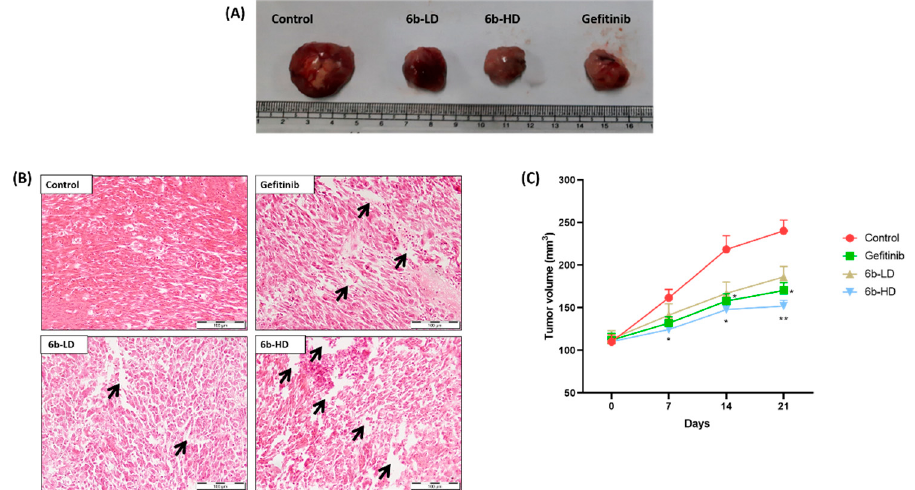
Figure 3. Effect of the 6b compound and gefitinib treatment on the tumor size in A549-induced lung cancer xenografts. ( A ) Representative photographic images of surgically removed tumors depicting tumor growth of xenograft nude mice from different groups in each group. ( B ) Changes in tumor volume of the animals from different groups throughout the treatment schedule. ( C ) Histopatho- logical analysis of tumors excised from tumor control (TC), 6b -low-dose- (LD = 10mg/kg), 6b -high- dose- (HD = 30mg/kg), and 30 mg/kg-gefitinib (GEF)-treated animals. The arrows depict the inter- stitial spaces in tumor samples. No such significant spaces were found in tumors of untreated ani- mals. All values are represented as mean±s.e.m. n=5; * p <0.05 vs tumor control, ** p <0.01 vs tumor control.